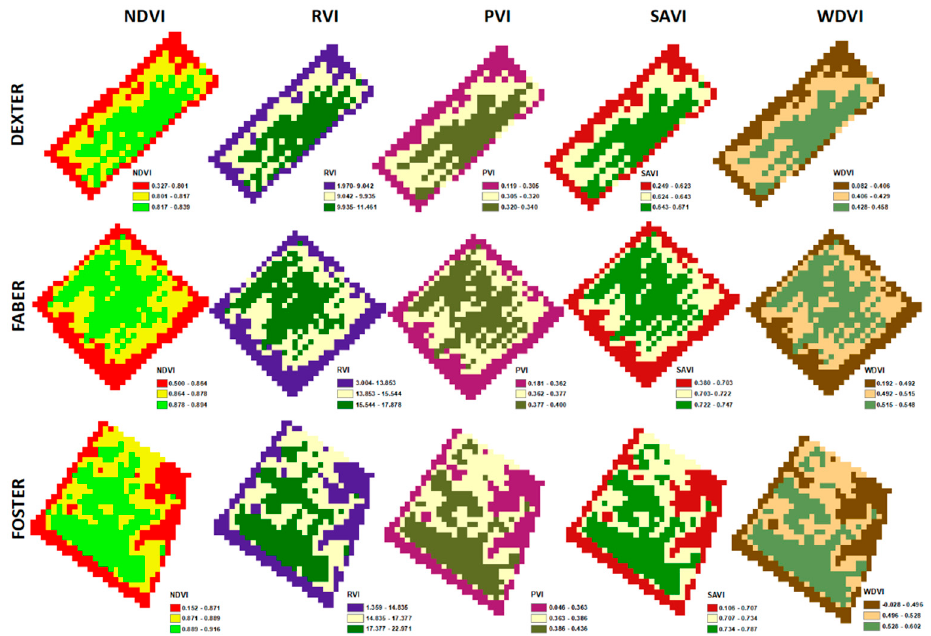
Figure 7. Example of the VI maps generated throughout the cultivation season at 90 days for the three varieties in quantile classification.